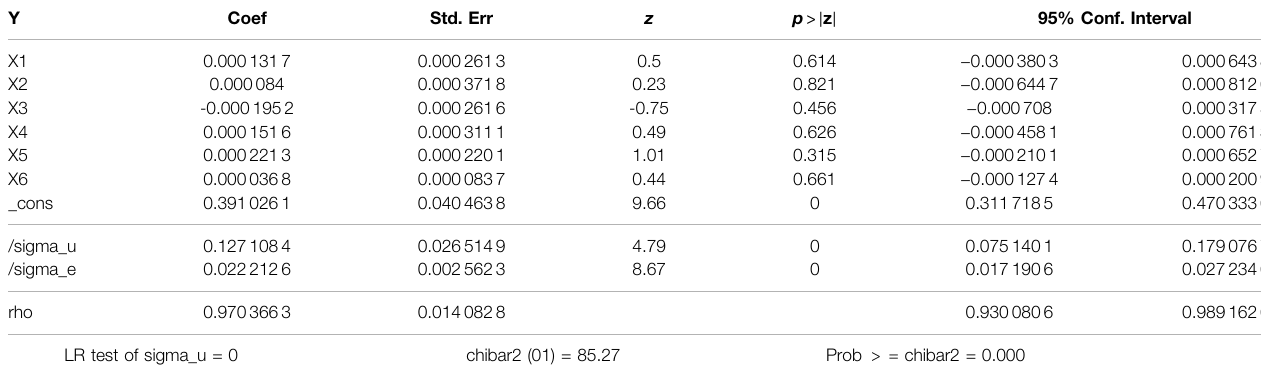
TABLE 6 | Output of tobit